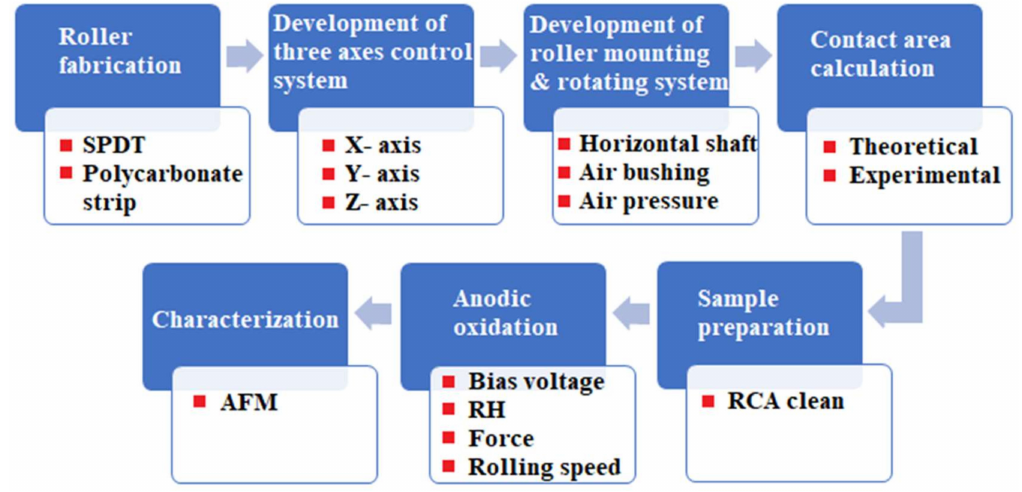
Figure 3. Process steps for the rolling NEL